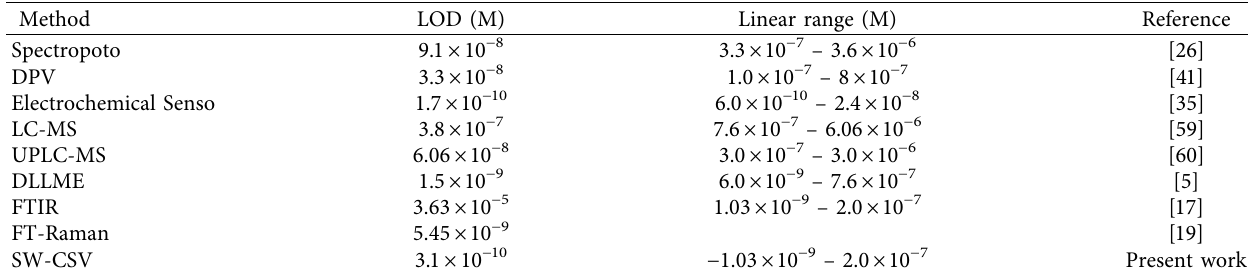
Table 1: Figures of merits ( µ g L − 1 ) of the developed SW-CSV and some of the published methods for malathion determination ∗ . Method LOD (M) Linear range (M)